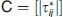
MDS maps: (a) 2-dimensional; (b) 3-dimensional.The matrix C=[|τij*|] is used.